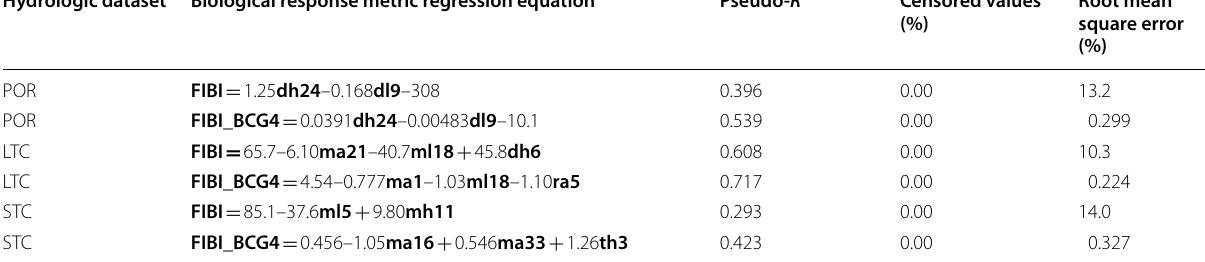
Table 5 Regression models and fit statistics for fish-based indices of biotic integrity (FIBI) scores and FIBI scores normalized to impairment threshold (FIBI_BCG4) for three hydrologic datasets: period of record (POR), long-term change (LTC), and short-term change (STC); see Table 1 for definitions of the biological metrics and Table 2 for definitions of the hydrologic metrics Hydrologic dataset Biological response metric regression